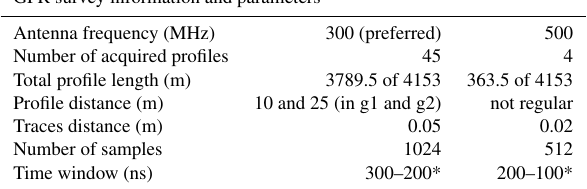
Table 1. Main information and GPR parameters used during the data collection (* the time window was adapted depending on the surveyed